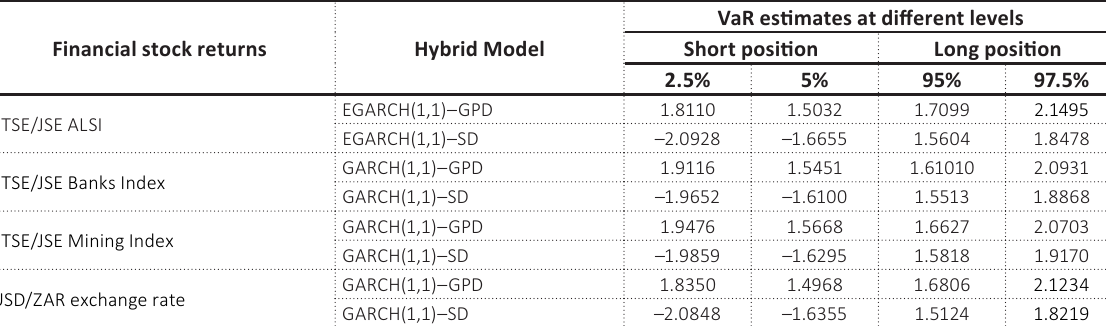
Table 7. VaR estimates of the financial market indices and exchange rate price returns using fitted hybrid GARCH-GPD and GARCH-SD